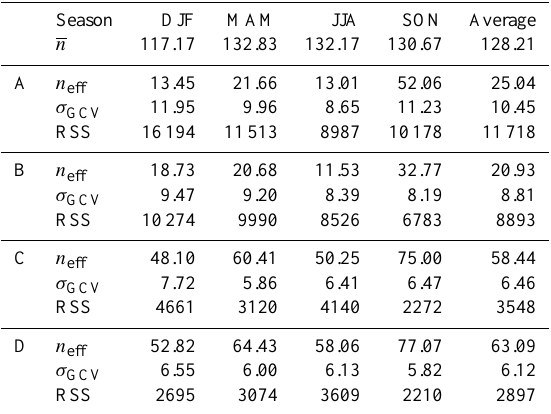
Table 3. Generalized cross-validation error ( σ GCV ) and residual sum of square (RSS) for different strategies averaged over 2000– 2005 by